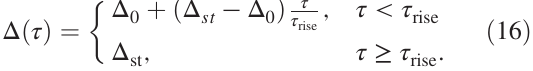
(b) of the first four azimuthal modes vs detuning parameter Δ for m